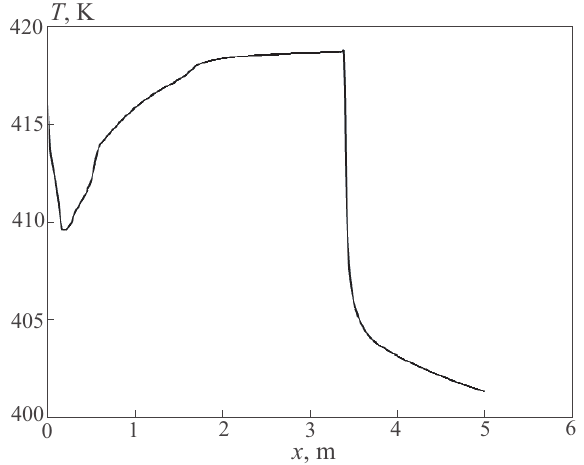
Figure 12. Temperature distributions along the pipe wall from the oil side. The distribution of the cross section-averaged oil pressure is shown in Figure 13. In this case, the pressure drop along the entire length of the pipe is 51,613.89 Pa.